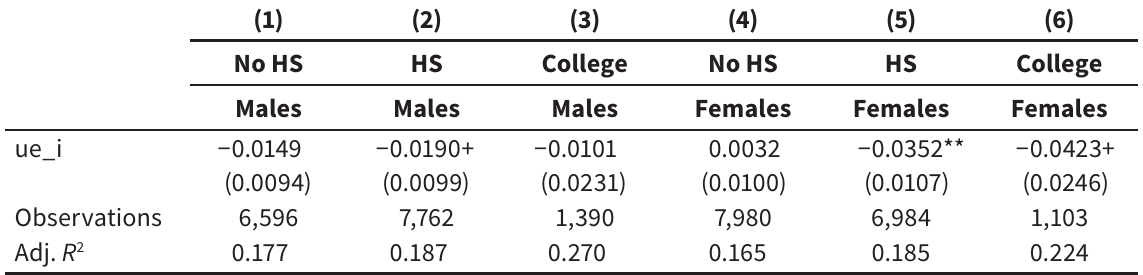
Heterogeneity within employment